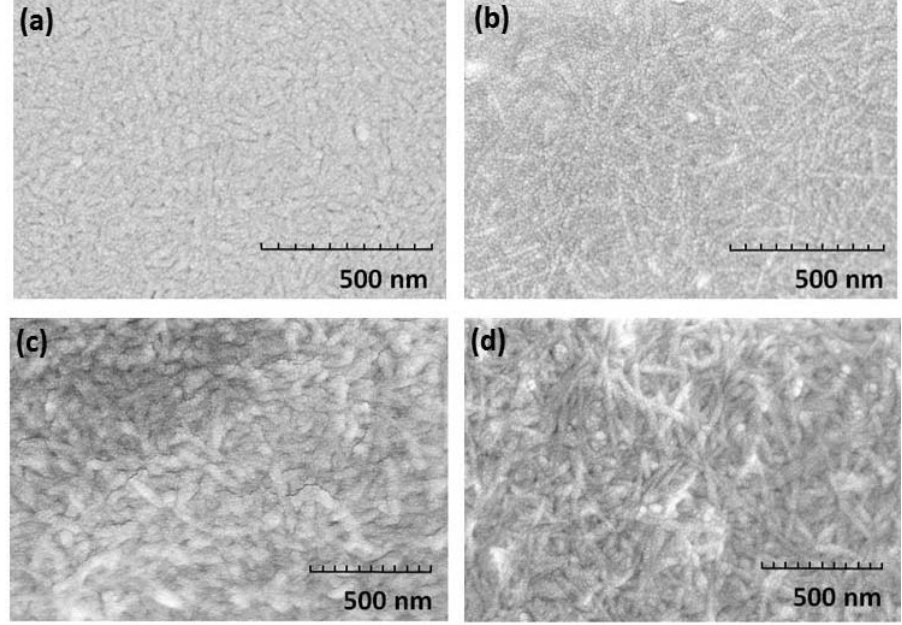
Figure 2. SEM images of films prepared from alkaline solutions of 3 from Avicel and cotton (( a , b ), respectively) and respective films after washing out alkali (( c , d ),